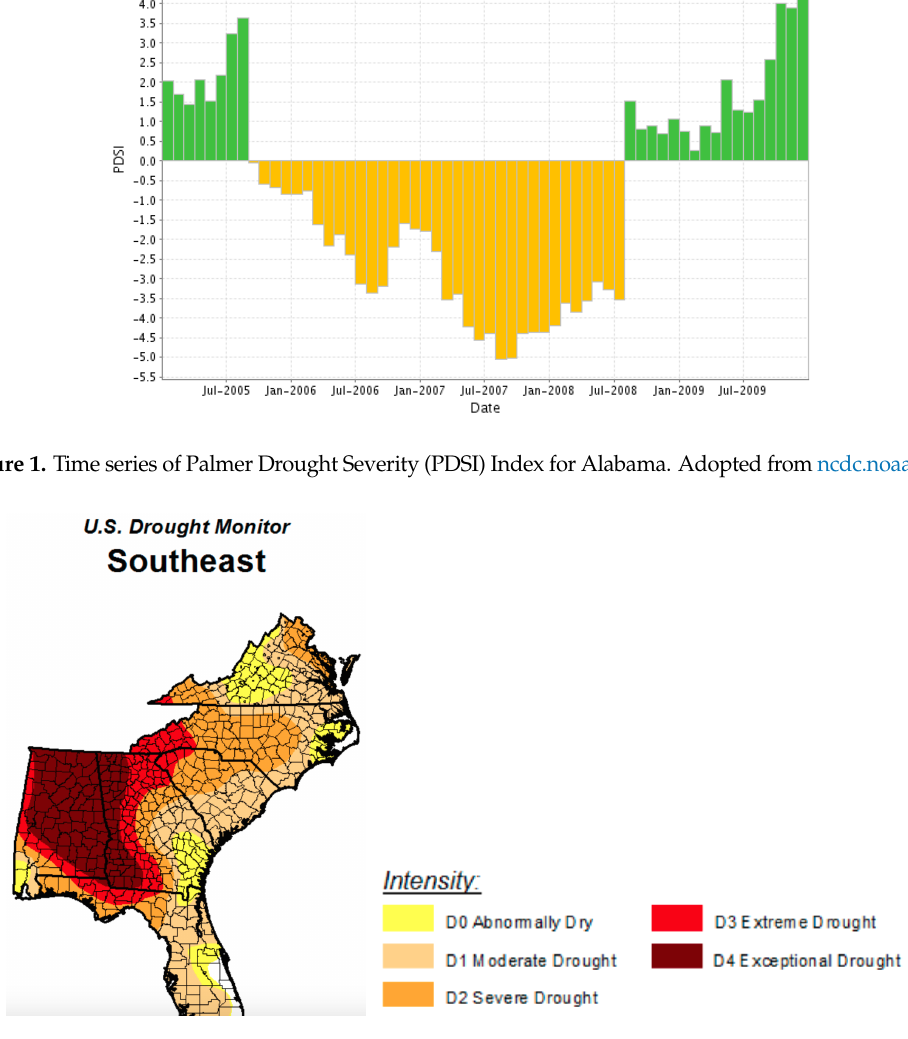
Figure 2. Drought distribution over the Southeastern US during the week of 14 August 2007, issued by the US Drought Monitor at